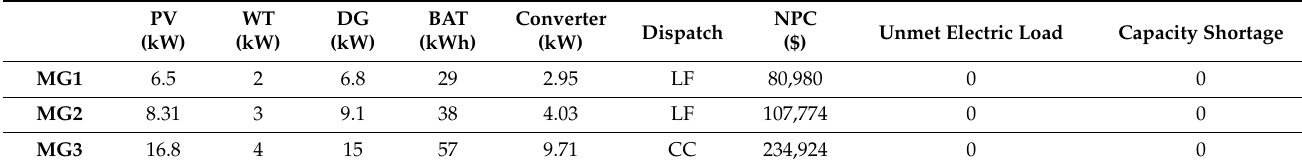
Table 3. HIMG optimal design by HOMER.